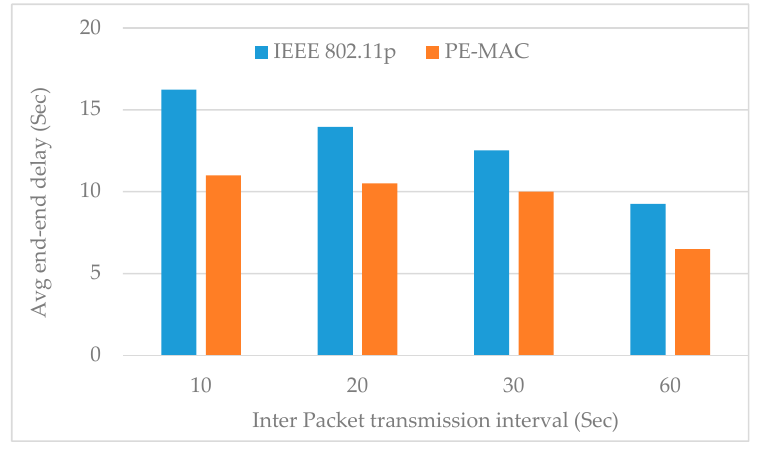
Figure 9. Impact of inter packet transmission interval on average end-to-end delay: proposed PE-MAC vs IEEE 802.11p.